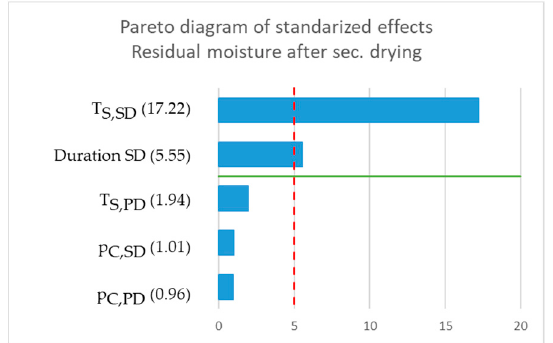
Figure 13. Pareto chart of standardized effects for residual moisture after secondary drying. Blue bars: absolute value of t-ratio; red dashed line: significance boundary; green line: separation of significant ( top ) and non-significant ( bottom ) parameters.